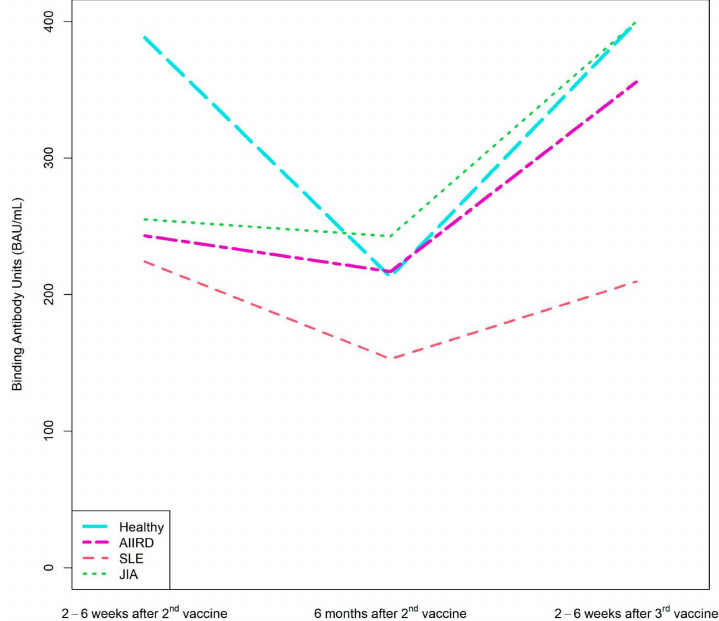
Figure 2. Kinetics of anti-S1/S2 IgG titers after the second BNT162b2 vaccine dose, 6 months later, and after the third dose in AIIRD patients grouped by diagnosis and in controls. AIIRDs, autoimmune inflammatory rheumatic diseases; JIA, Juvenile Idiopathic Arthritis; SLE, Systemic Lupus